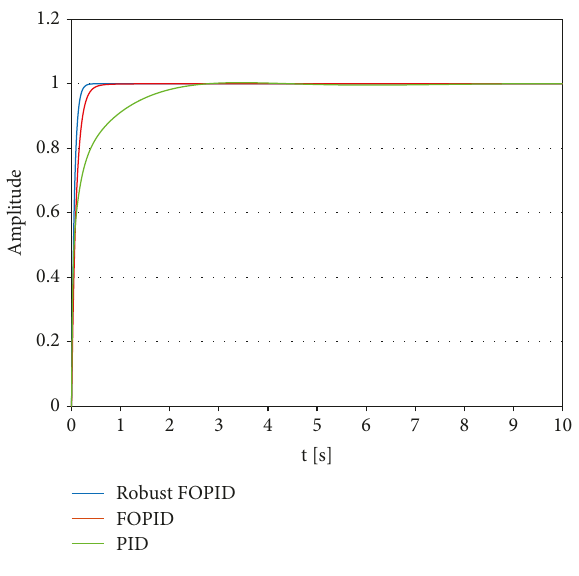
Figure 9: Step response comparison of G